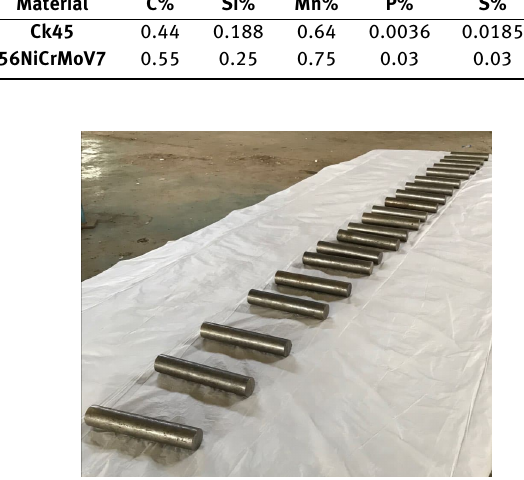
Table 1: Chemical compositions for tool steel and workpiece Material